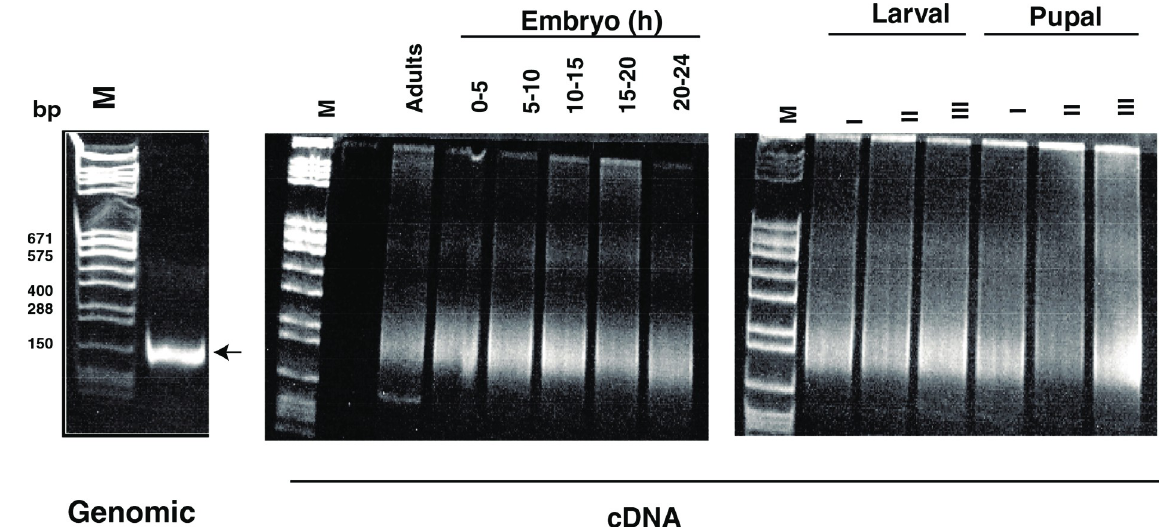
Fig 2. PCR products of the genomic and cDNA libraries. The source of DNA ( Drosophila DNA) or mRNA from various developmental stages are shown at the top: embryonic 0–5 hrs, 5–10 hrs, 10–15 hrs, 15–20 hrs, and 20–24 hrs; larval I, II, and III instar stages; pupal I, II, and III instar stages; and adult flies. Arrow indicates the size (approximately 150 basepairs of the genomic library). Approximately 220–350 basepairs PCR products were excised for each of the cDNA libraries. Size markers are marked by the lanes labeled M.